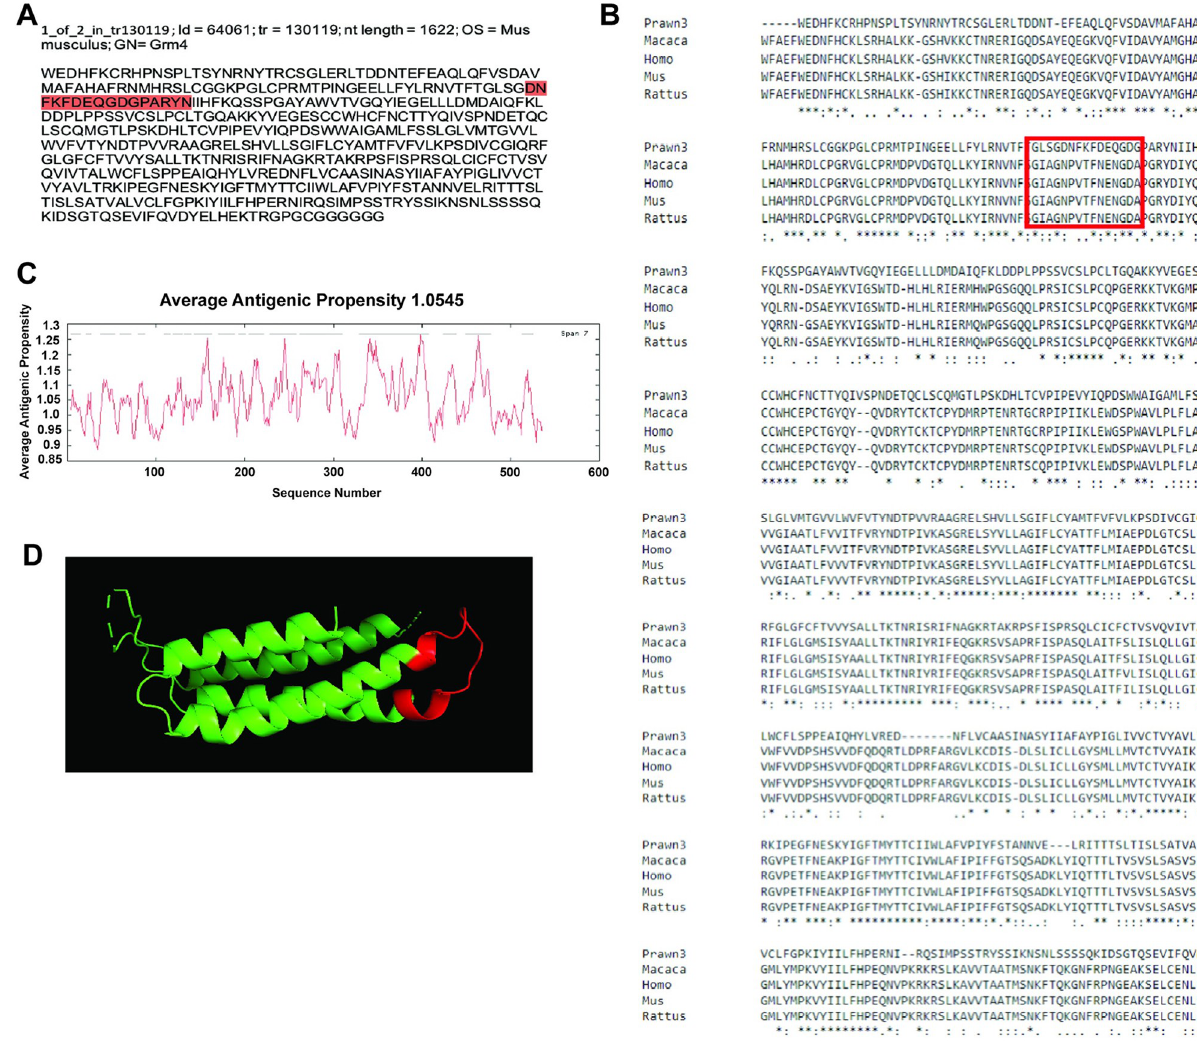
Fig 4. Contig annotated as metabotropic glutamate receptor 4 (mGluR4) analysis for antibody production. A) Contig identifiers for mGluR4 in the M . carcinus transcriptome and its sequence translated into amino acids for further analysis. B) Multiple sequence alignments of the prawn´s contig compared to the same protein in other species: non-human primate M . mulatta , human primate H . sapiens , rodent M . musculus , and rodent R . norviscus . Regions of conserved amino acids are shown within the red box. C) Average antigenic propensity value was 1.0545, showing 18 determinants (peaks in graph) within the sequence that are good candidates for antigenic response. D) A 3D reconstruction model showing tertiary structures of the prawn mGluR4 contig sequence. The red highlight in A, rectangle in B, and segment in D represent the selected sequence for antibody production.